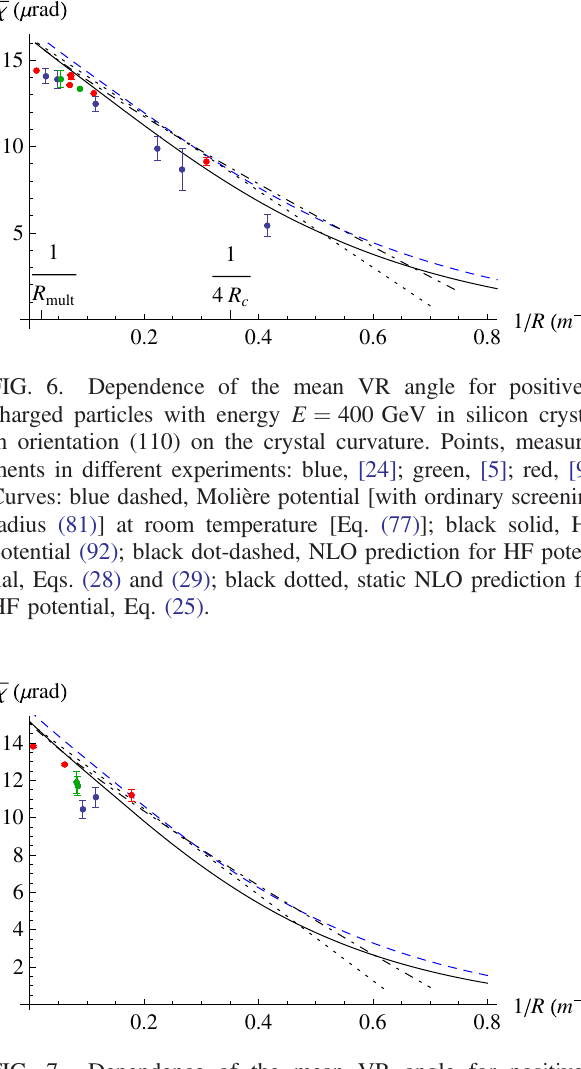
FIG. 9. E=R dependence of the mean VR angle for negatively charged particles in silicon crystal in orientation (110). Points: blue, measurement [7] for E ¼ 150 GeV and R ¼ 22 . 79 m; green, measurement [11] for E ¼ 120 GeV and R ¼ 2 . 71 m. Curves: the same as in Fig.